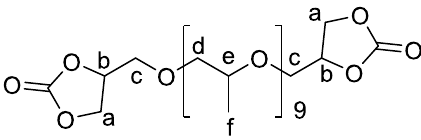
Figure 8. PPO DC structure. 1 H NMR (400 MHz, CDCl 3 , p pm): δ = 1.15 (d, 21H, CH 3 , H f ), 3.33-3.95 (m, 25H, H c , H d